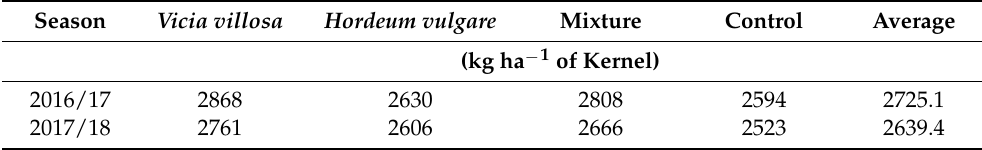
Table 3. Almond production per cover crop and